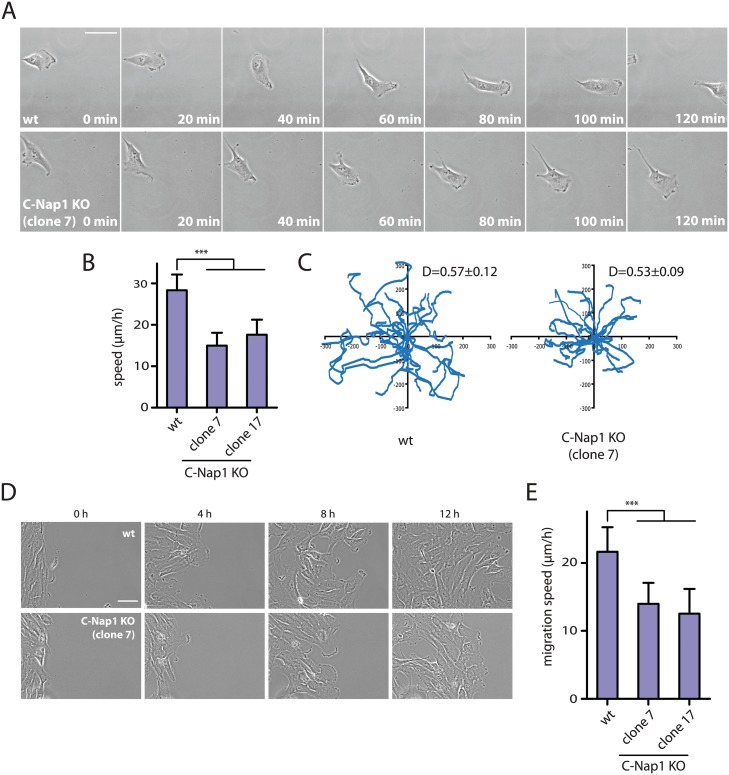
RPE1 C-Nap1 KO cells have reduced migration speed.(A) Analysis of migration speed of RPE1 wt and RPE1 C-Nap1-KO cells. Phase contrast images of migrating cells over time. Bar: 30 μm. (B) Quantification of migration speed of cells from (A). Two independent C-Nap1 KO cell lines were analyzed. RPE1 C-Nap1 KO cells have reduced migration speed compared to RPE1 wt cells. N = 20–30. Bars are SEM. *** p<0.001 (C) Tracking of RPE1 wt and RPE1 C-Nap1 KO cells. The results of the manual cell tracking over a period of 10 h are shown (interval time—15 min). RPE1 wt and RPE1 C-Nap1 KO cells did not show a difference in migration directionality. Values of the directionality index (D±SEM) are shown at the upper right corner of the graph. (D) The wound healing assay showed that C-Nap1 KO clones have a reduced migration speed. Bar 50 μm. (E) Quantification of (D) shows that C-Nap1 KO clones 7 and 17 have reduced migration speed compared to the RPE1 wt control, but to a slightly lesser extent in comparison to the random migration results from (A). Bars are SEM. N = 25–30, *** p<0.001.